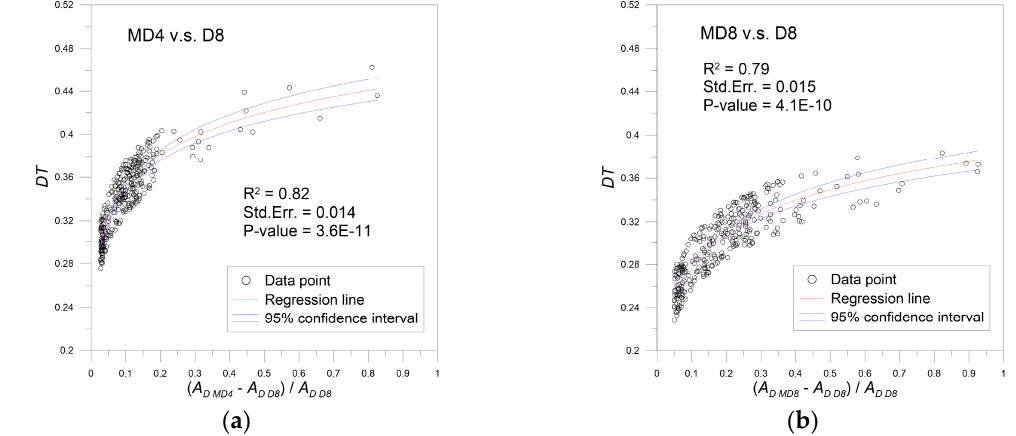
Figure 11. Relationship between the peak-time deviation ( DT ) and the variance of flow dispersion area: ( a ) MD4 compared to D8; ( b ) MD8 compared to D8.